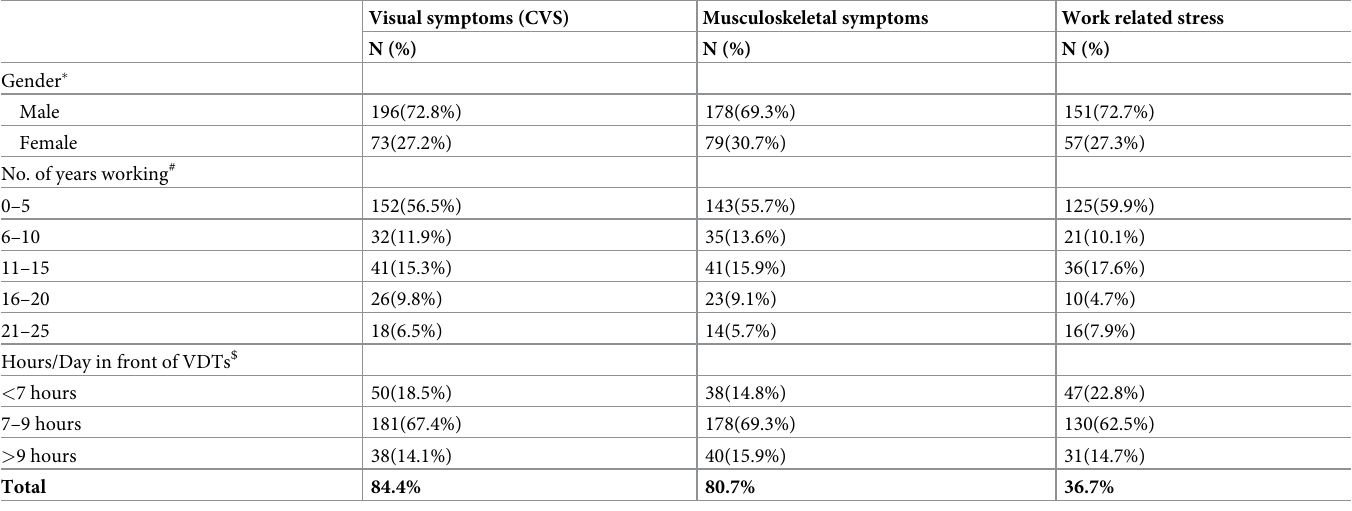
Table 5. Prevalence of CVS symptoms, musculoskeletal symptoms and work-related stress.